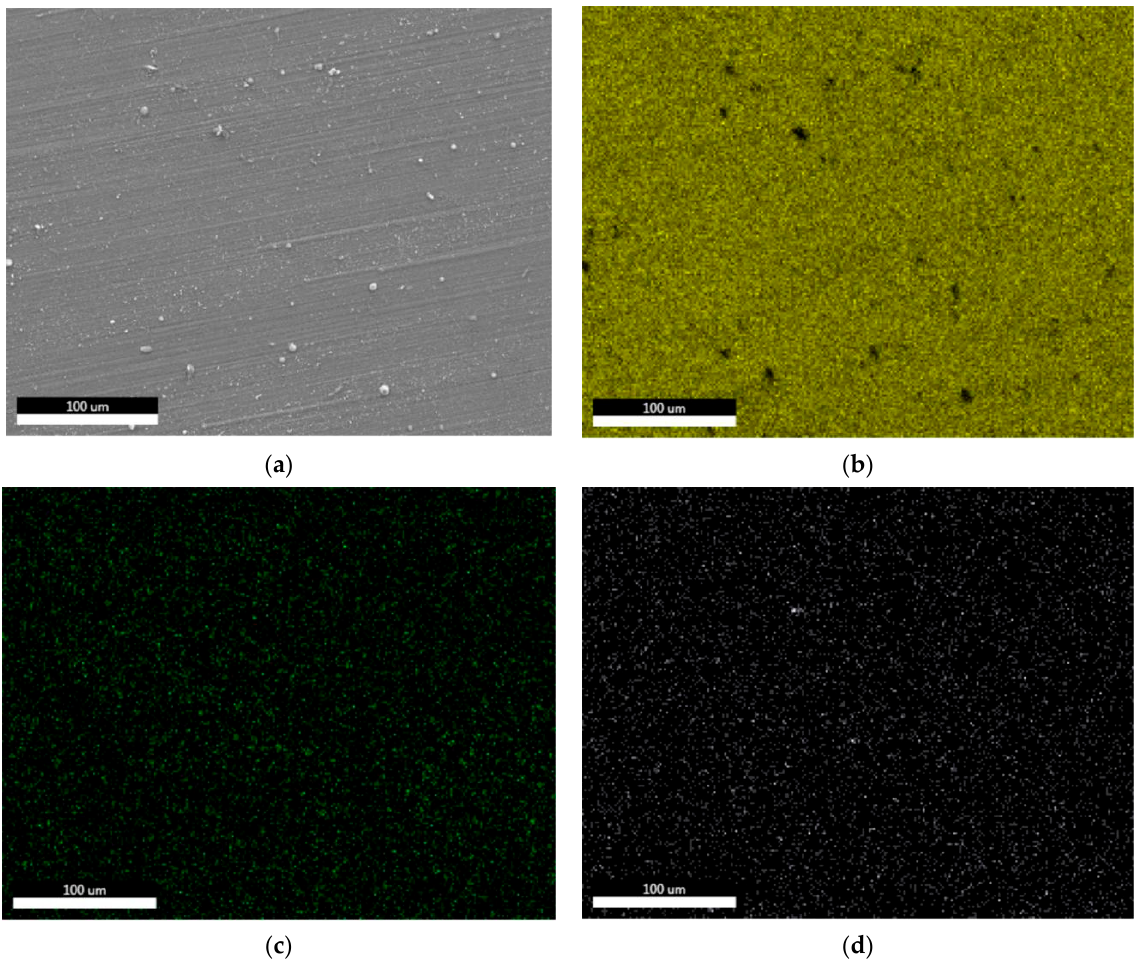
Figure 7. FESEM-EDX elemental area mapping of the Mg-3Sn + 0.2 GNP nanocomposite: ( a ) FESEM image of a selected area, ( b ) Mg, ( c ) Sn, and ( d ) Carbon (GNP).